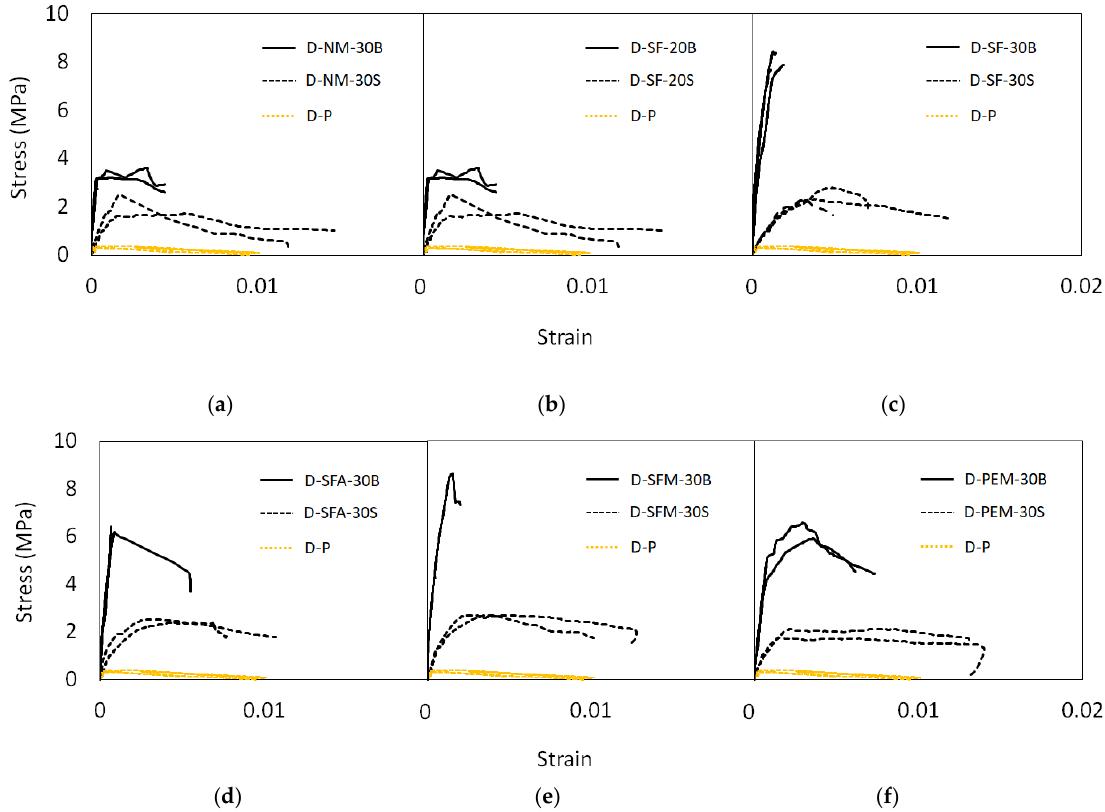
Figure 7. Diagonal tension stress–shear strain curves: ( a ) D-NM-30S and D-NM-30B; ( b ) D-SF-20S and D-SF-20B; ( c ) D-SF-30S and D-SF-30B; ( d ) D-SFA-30S and D-SFA-30B; ( e ) D-SFM-30S and D-SFM-30B; ( f ) D-PEM-30S and D-PEM-30B. Table 5. Diagonal tension strength test results.